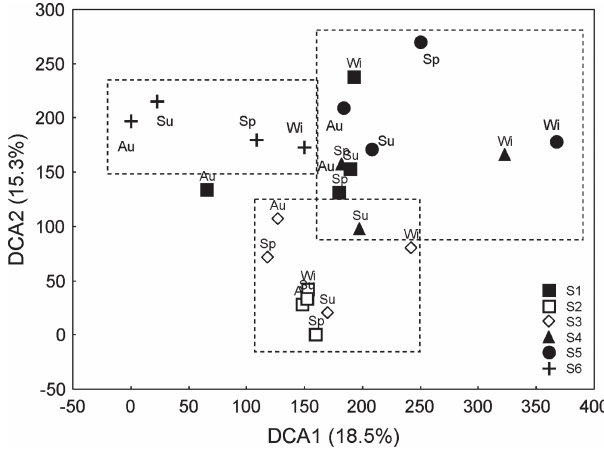
Fig. 5. Detrended Correspondence Analysis (DCA) applied to ordinate samples according to variations in fish composition and abundance along the Uruguay River. Rectangles depict groups confirmed by a Multiple Response Permutation Procedure (Tab. 2). Sites: S1 = upstream; S6 = downstream. Seasons: Au= Autumn; Sp= Spring; Su= Summer and Wi= Winter.